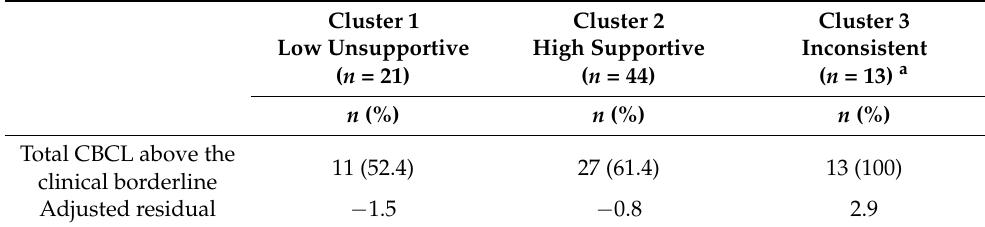
Table 5. Distribution of children above the clinical borderline level between parents’ reactions clusters: Absolute, relative frequencies, and adjusted residuals.